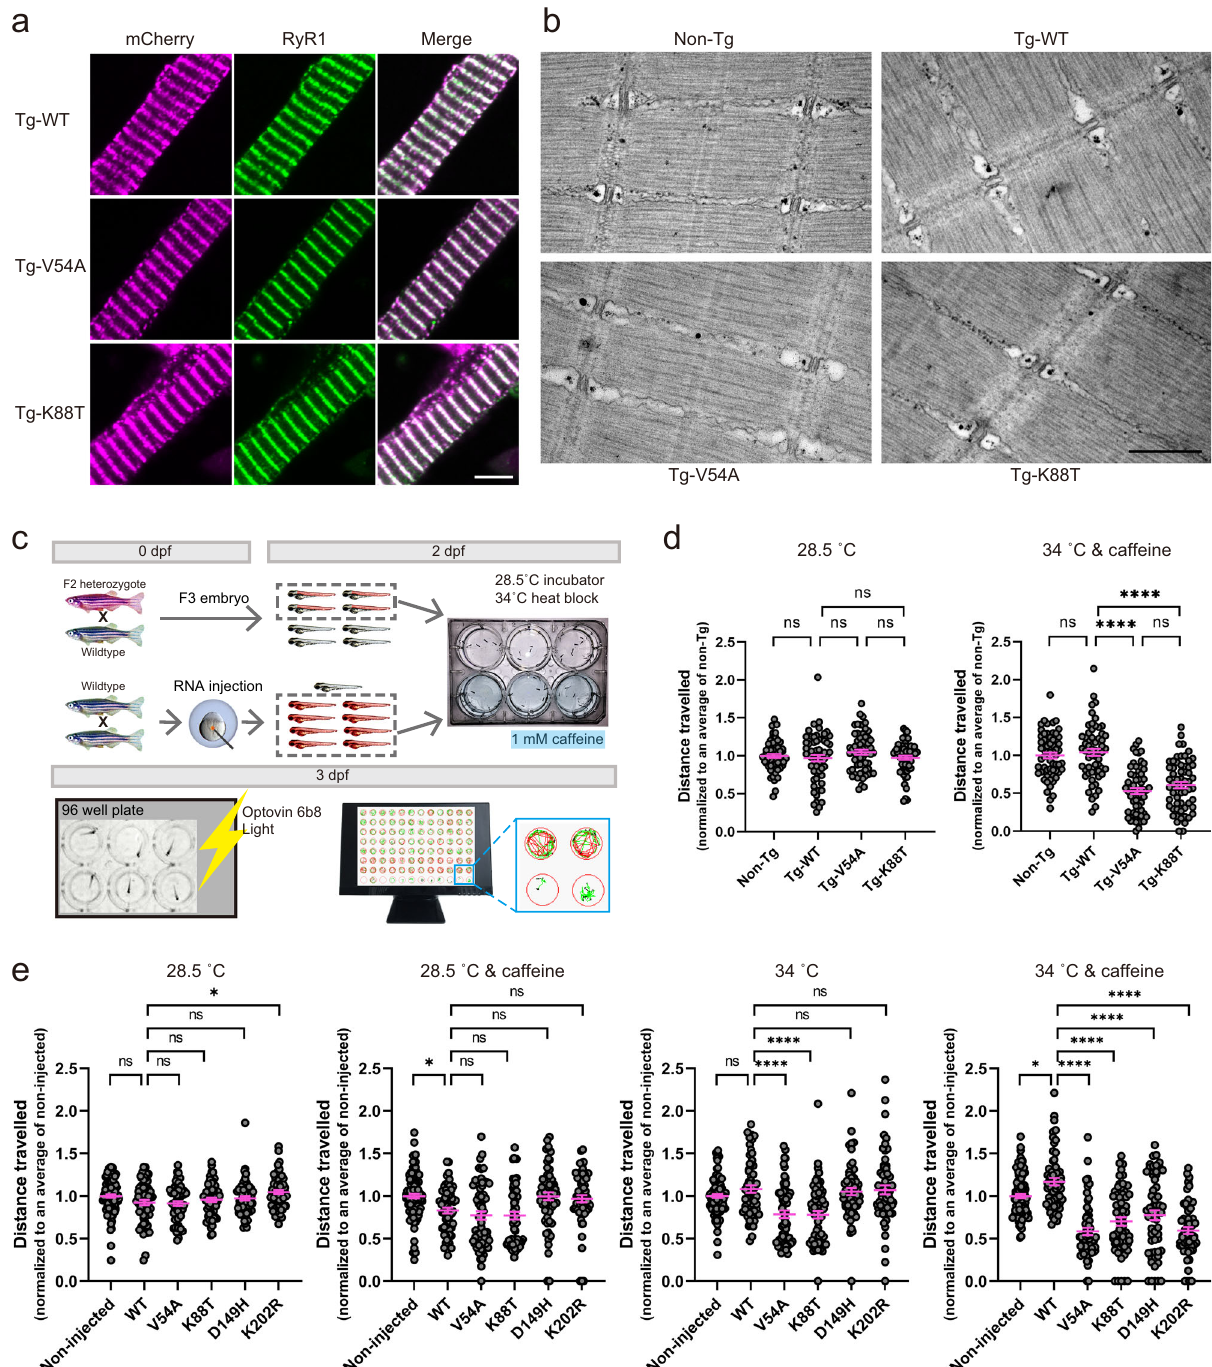
Fig. 2 Junctin variant transgenic zebra fi sh exhibit heat- and caffeine-induced motor defects. a Immunolabeling of myo fi bers isolated from transgenic (Tg)-WT, Tg-V54A and Tg-K88T zebra fi sh with anti-mCherry and anti-RyR1antibodies. Magenta: mCherry, green: RyR1, scale bar: 5 μ m. b Representative electron microscopy images from muscle of non-Tg, Tg-WT, Tg-V54A, and Tg-K88T zebra fi sh. Scale bar: 500 nm. c An overview of the work fl ow of the Heat + Caffeine assay. d Swimming ability of junctin mutant transgenic fi sh is altered with heat + caffeine exposure. Fish were tested without treatment (left panel) or with 1 mM caffeine at 34 °C for 1 h (right panel). Distance traveled was measured and normalized to the mean of non-Tg tested from the same day. Each group consists of 60 fi sh, which were obtained from three independent experiments with 20 fi sh per group. Error bars represent SEM. e Synergistic effect of heat and caffeine on the swimming ability of fi sh injected with junctin mRNA. Scatter plots display the total distance traveled normalized to the mean of non-injected measured on the same day. Data from non-injected ( n = 100) and the other groups ( n = 60) were from independent experiments with 20 animals per group at a time. The treatment conditions for each are no treatment (the leftmost panel), 1 mM caffeine at 28.5 °C for 1 h (the second panel from the left), at 34 °C for 1 h (the second panel from the right), and 1 mM caffeine at 34 °C for 1 h (the rightmost panel). Error bars represent SEM. Statistical analysis for ( d , e ) by one-way ANOVA followed by Tukey ’ s ( d ) and Dunnett ’ s ( e ) multiple comparisons tests where * p < 0.05, *** p < 0.001, **** p < 0.0001. Source data are provided as a Source data fi